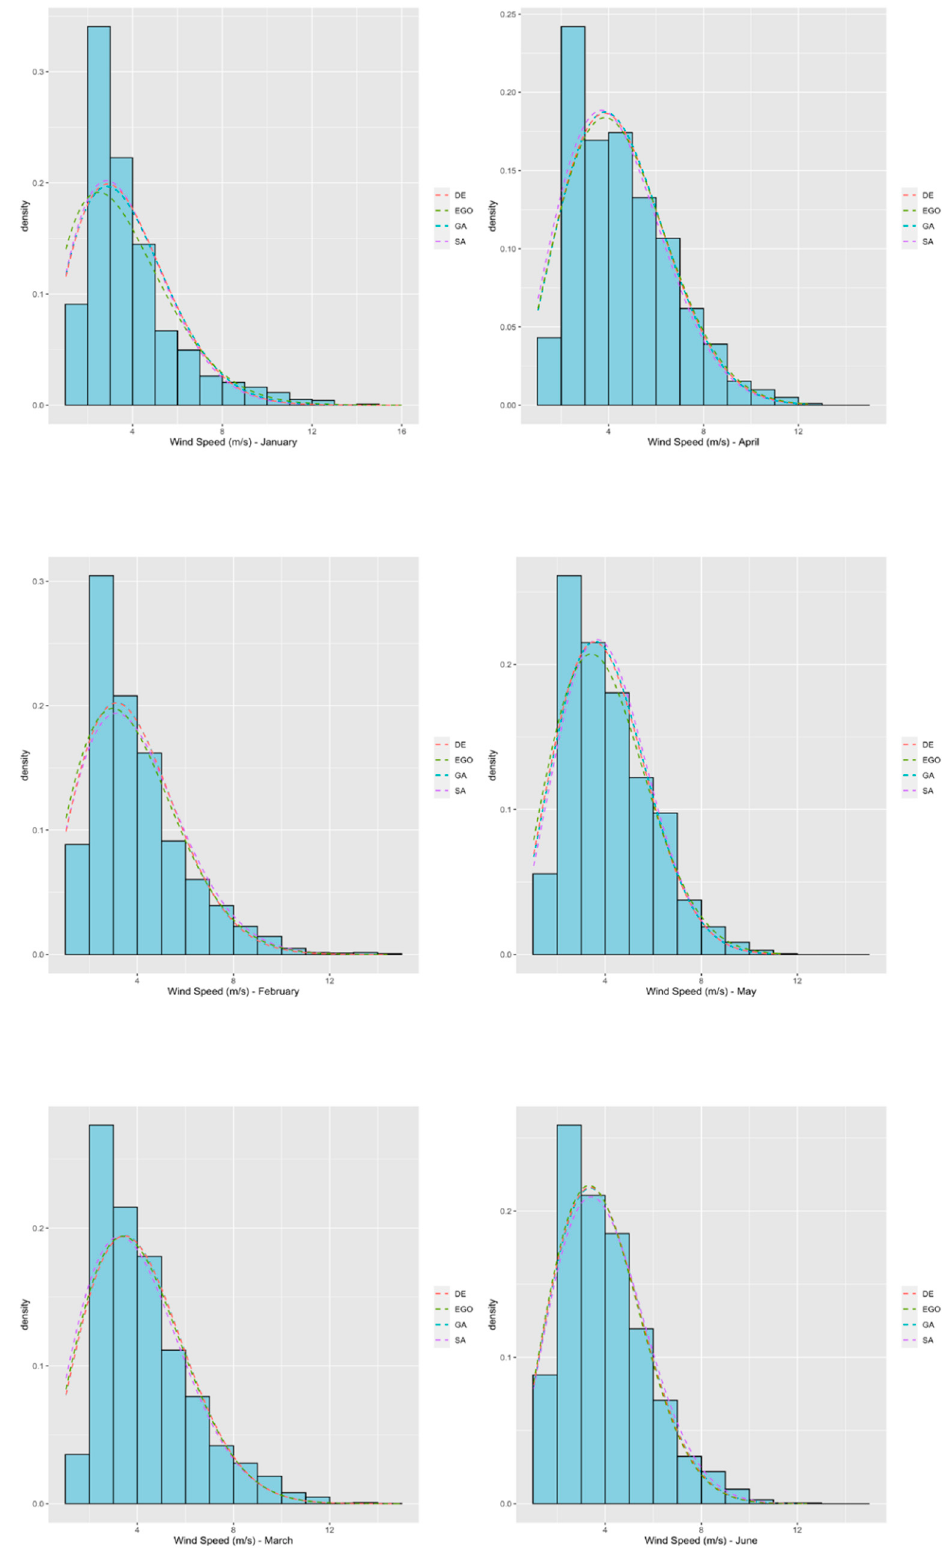
Figure 8. Monthly probability density function estimation and monthly histograms of observed WS data (from January to June) (own elaboration).